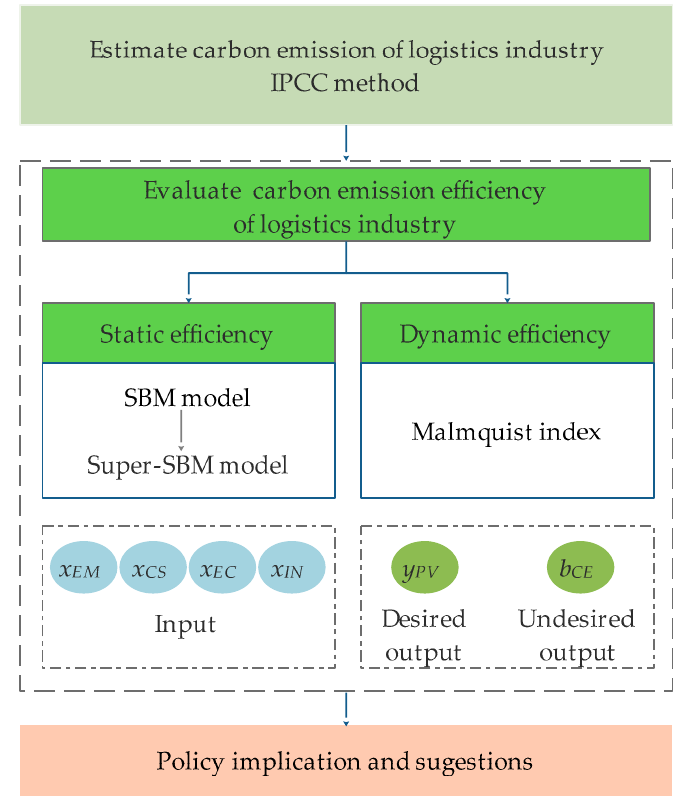
Figure 1. The research framework. IPCC: Intergovernmental Panel on Climate Change; SBM: slack-based measurement.